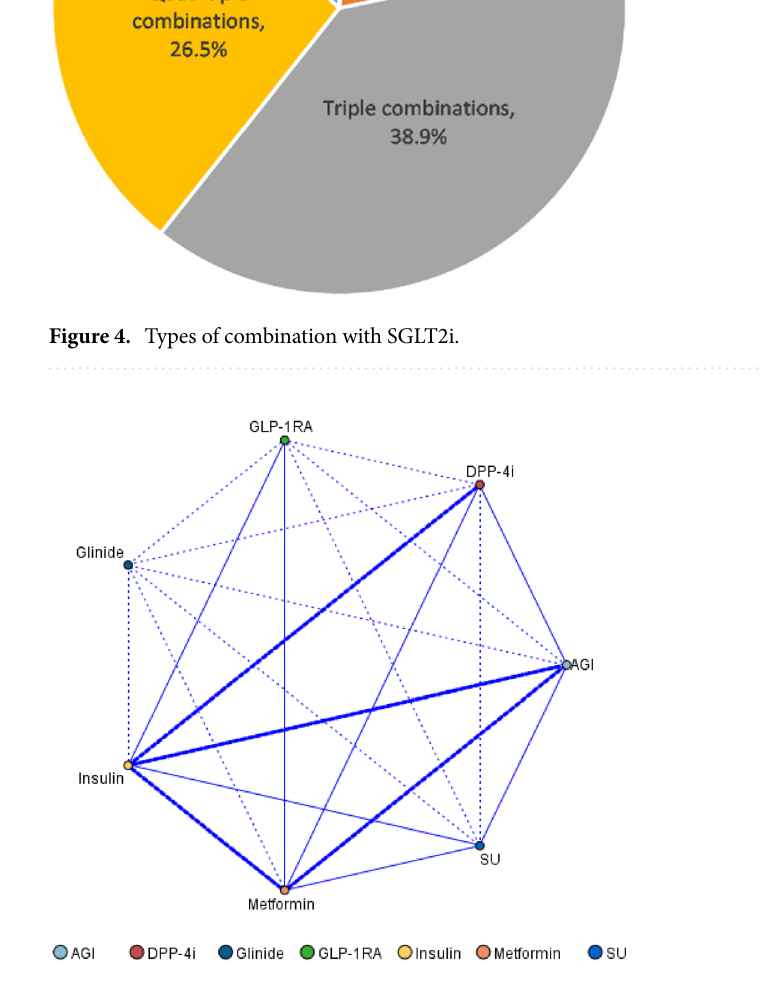
Figure 5. Network diagram of hypoglycemic drugs used in combination with SGLT2i. The network diagram indicates the class and frequency of other hypoglycemic agents used in combination with SGLT2i. Dot refers to each hypoglycemic agent. Line refers to the combination of each two hypoglycemic agents. The combined frequencies ≥ 25% are indicated by a thick line, the combined frequencies ≤ 10% are indicated by a dashed line, and the combined frequencies in between are indicated by a thin solid line. AGI, alpha-glucosidase inhibitors; DPP-4i, dipeptidyl peptidase-4 inhibitors; GLP-1RA, glucagon-like peptide-1 receptor agonists; SU,